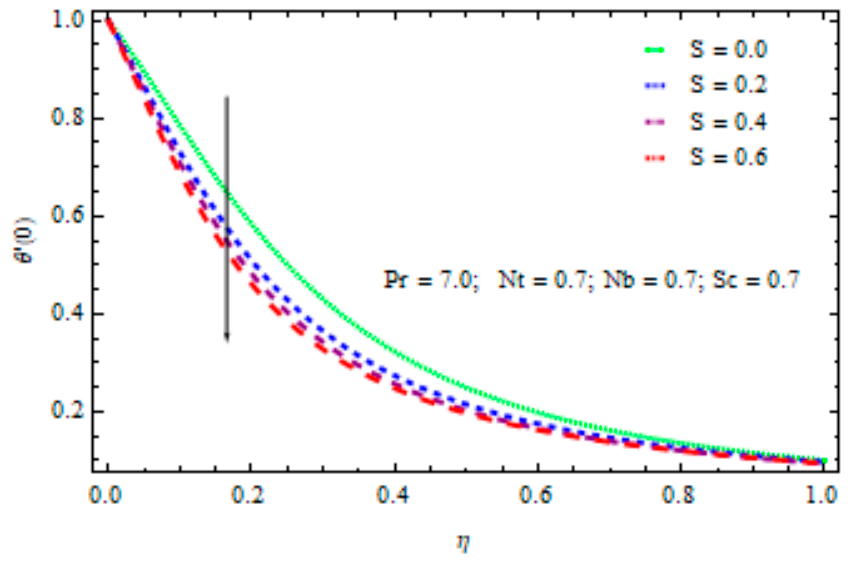
Figure 12. The impact of the unsteady parameter S on the induced flow in the y-direction.